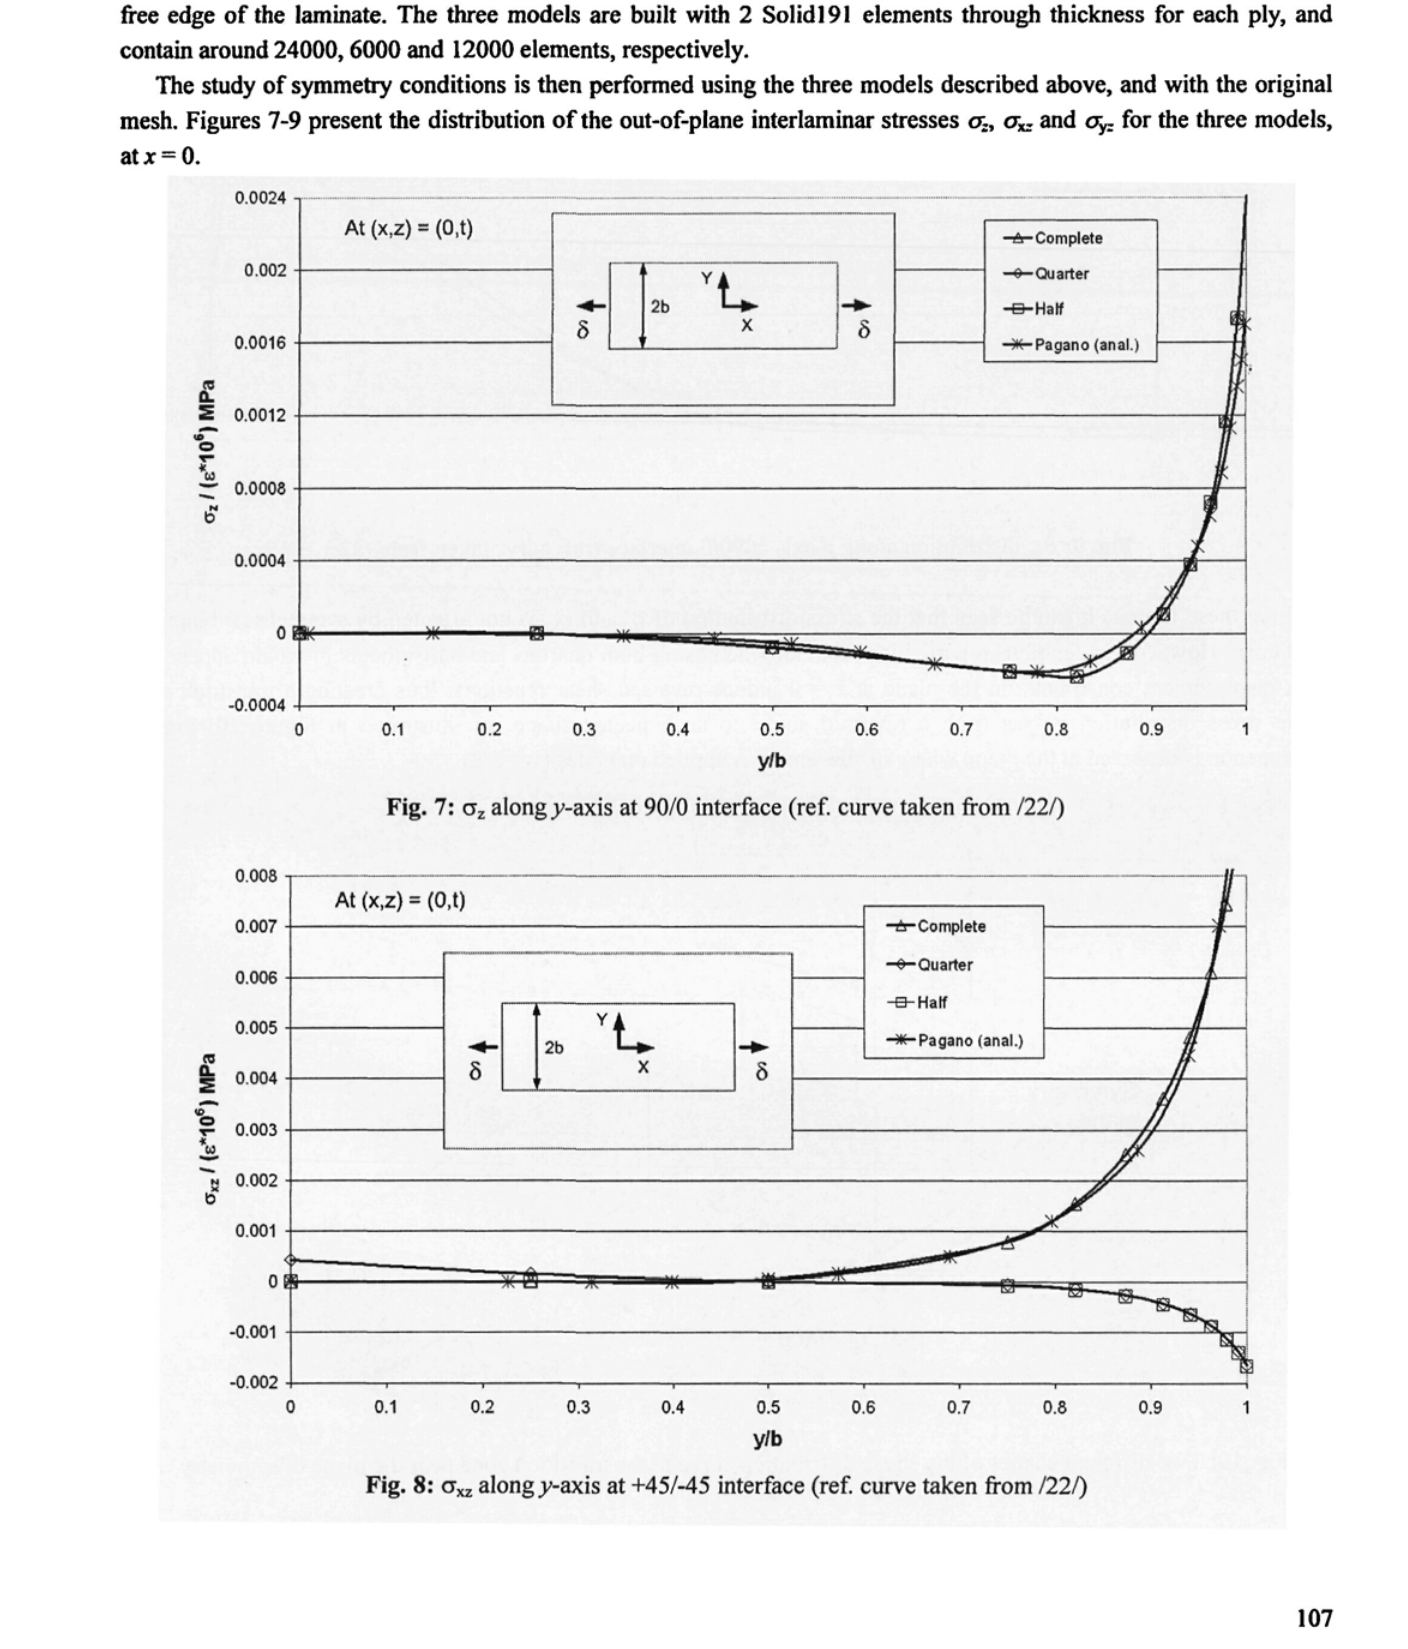
Fig. 8: σ^ along y-axis at +457-45 interface (ref. curve taken from